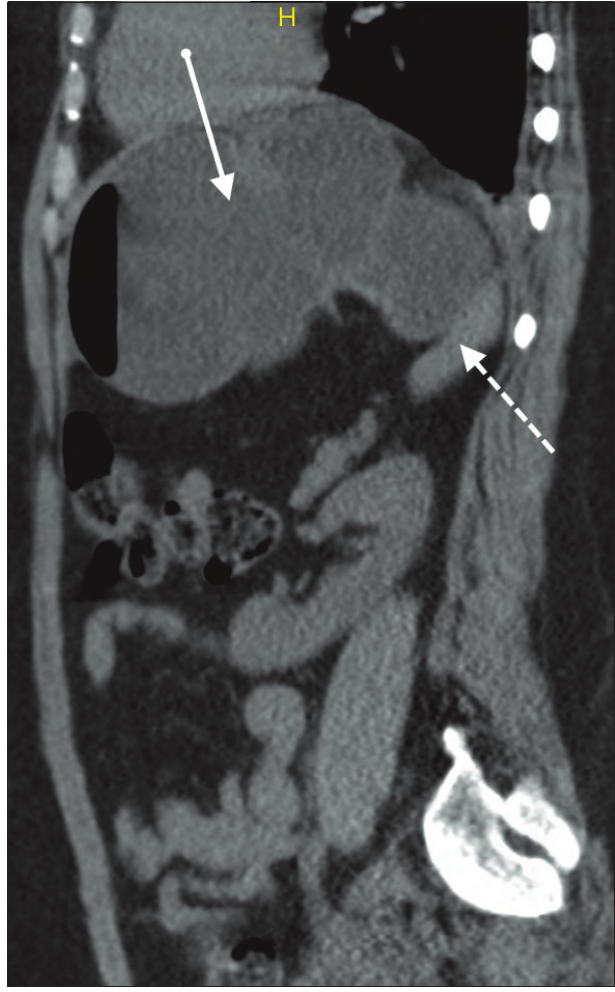
Fig. 2. Sagittal CT image demonstrating the abnormal horizontal orientation of the stomach (solid arrow). The spleen is indicated (broken arrow).